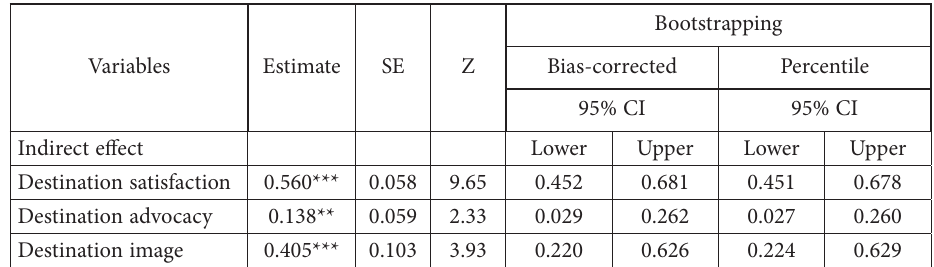
Table 5. Mediation